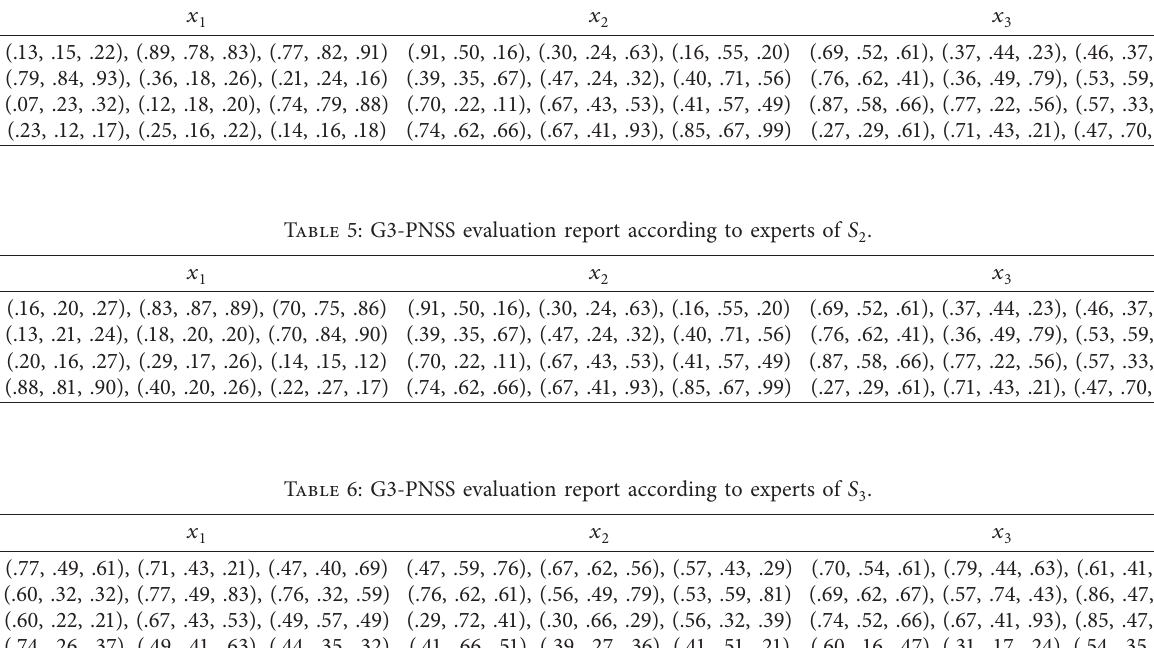
Table 4: G3-PNSS evaluation report according to experts of S